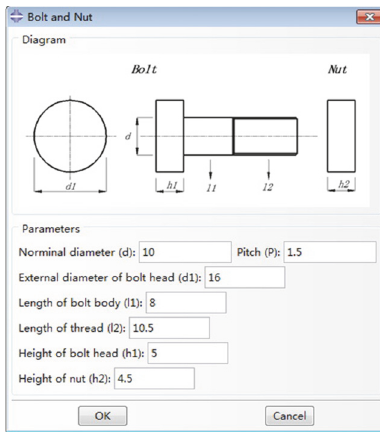
Figure 4: The parametric modeling